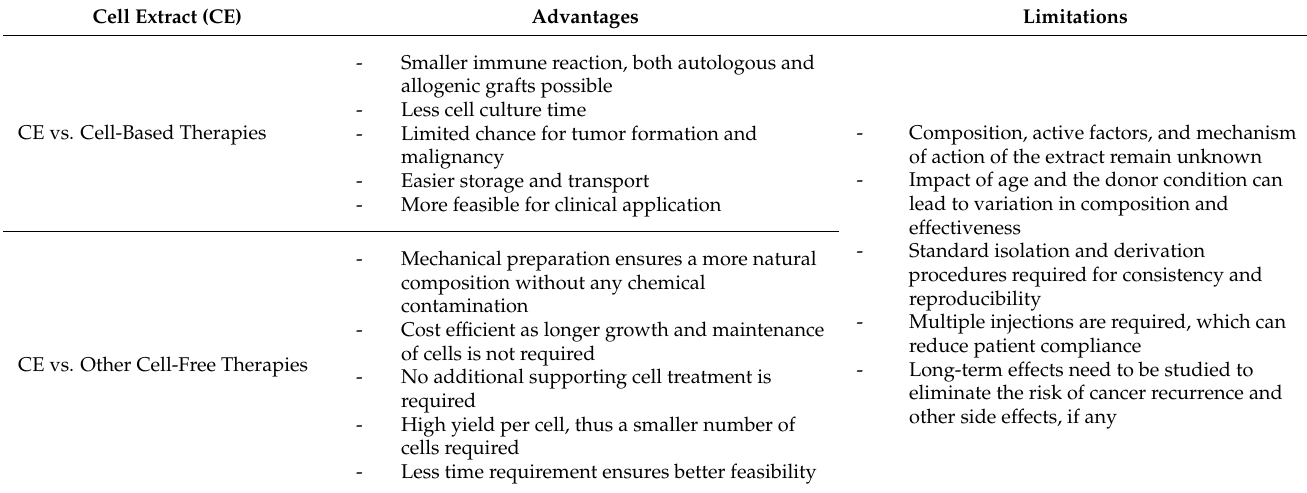
Table 5. Comparison of cell extract therapy to other stem cell